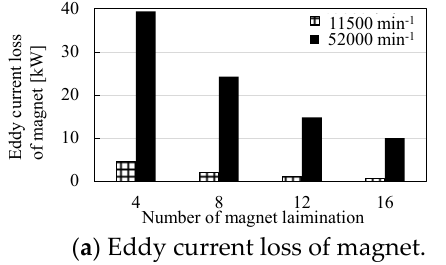
Figure 23. Eddy current loss of PMSM.